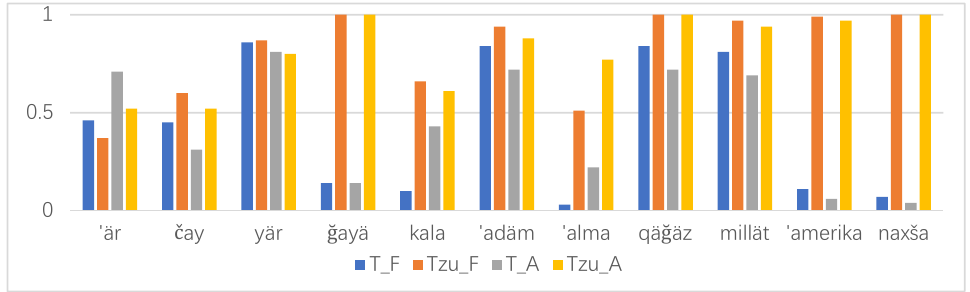
Figure 2. BM-U and BM algorithm F1-measure value (F) and accuracy (A) comparison of weakened words (u means BM-U algorithm).